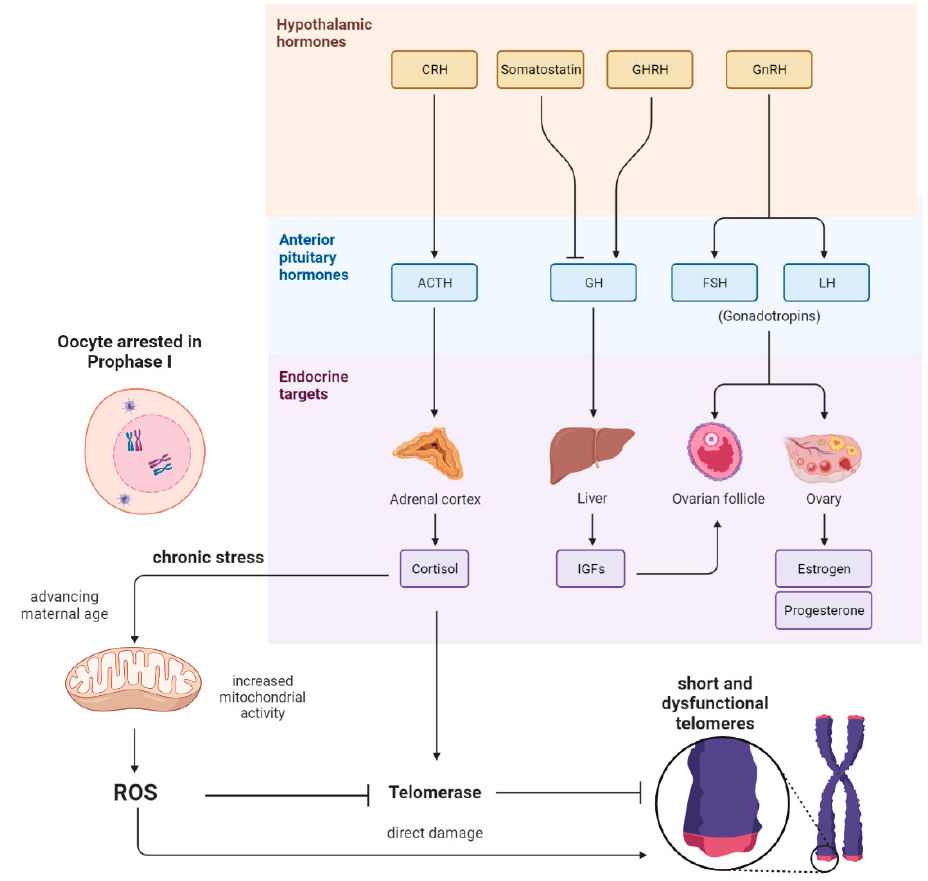
Figure 1. Scheme showing the pathways and interplay between the endocrine system and the reproductive system and their potential influence on the oocyte. After the hypothalamic CRH and ACTH from the pituitary gland are released, cortisol is secreted by the adrenal cortex. In consequence, there is elevated mitochondrial activity in somatic cells; therefore, reactive oxygen species (ROS) are generated. High levels of ROS could cause the oxidation of guanin-rich telomeres in women’s oocytes. Cortisol might also affect telomerase activity directly. Further, IGF1, FSH, and LH do also influence the development and maturation of ovarian follicles, which indirectly appear to influence the aging of oocytes when ovulations are altered.